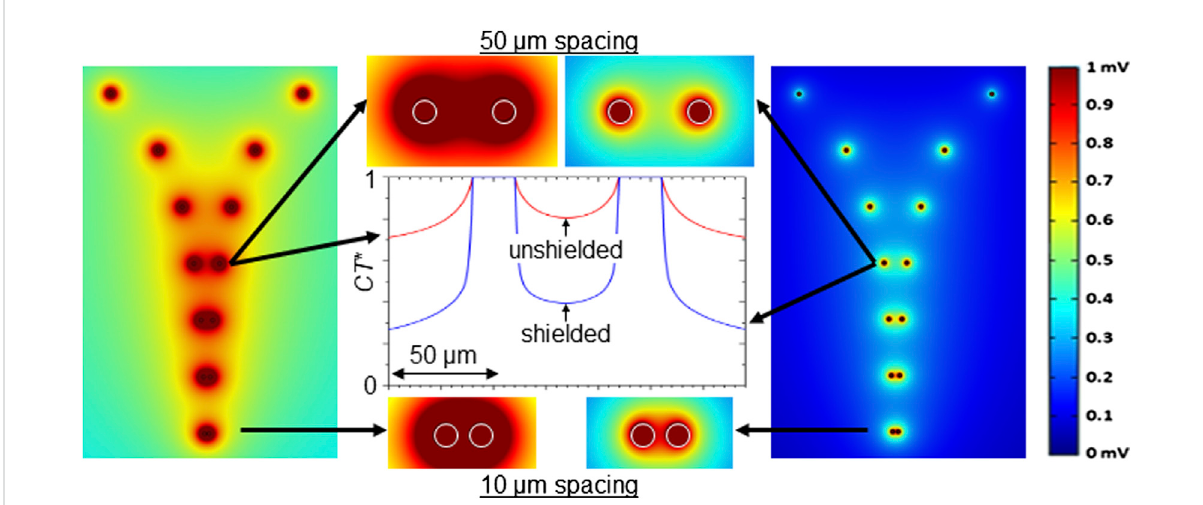
FIGURE 2 Finite element modeling. Top view of simulated equipotential contours for (left) bare and (right) shielded electrodes (5 μ m height, 20 μ m- diameter),biasedat1 mV,withelectrodespacings,fromthetopof1,000,500,250,100,50,25,and10 μ m.Colorbaratfarrightindicatesstrengthof signal from a source (e.g . , action potential/neuron spike)sensed by an electrode. Middle panel shows magni fi edview of50 and 10 μ m spacing rows, as well as calculated CT* values versus distance for the 50 μ m spacing. The coaxial, shielded electrodes include simulated radially coatings of 200 nm Al 2 O 3 and 120 nm Cr, the latter with height 3 μ